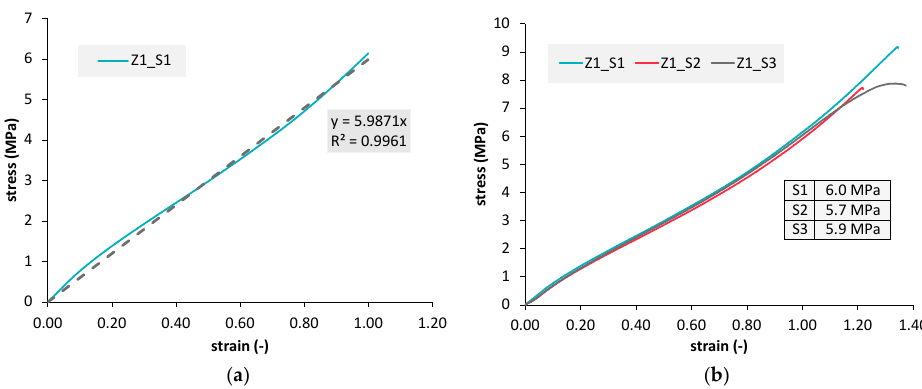
Figure 8. Exemplary evaluation using a regression line (dashed) ( a ); identified engineering stress–engineering strain curves of the tensile tests on round tensile bars ( b ) with a table of results for the Young’s modulus.